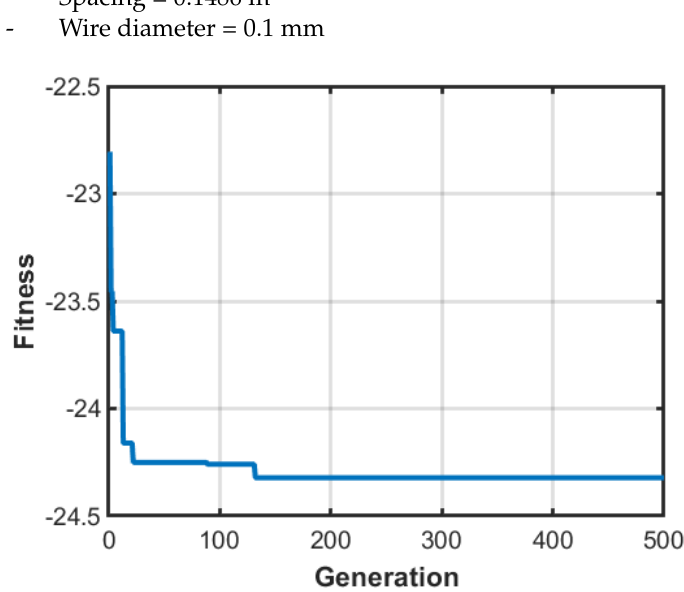
Figure 9. Fitness versus generation, fitness defined as the average return losses at the frequency band and central frequency as Equation (29).